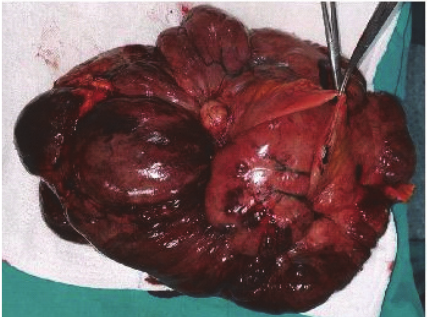
Figure 2: En bloc resection specimen: large mass with a 20 cm jeju- nalsegment(surgicalclampsholdingtheproximalanddistalstapled ends) left pelvic side wall peritoneum and omentum